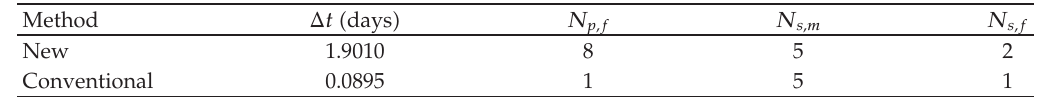
Table 4: Comparison of Example